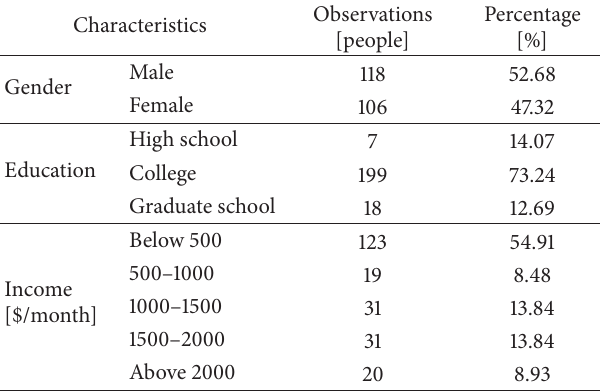
Table 3: The most frequently observed (bold) and second-most frequently observed (italic) regions.